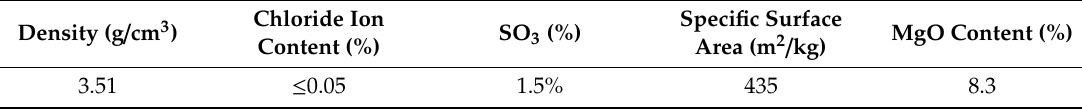
Table 3. Physical properties of slag powder. Table 4. Physical properties of single-particle gangue.